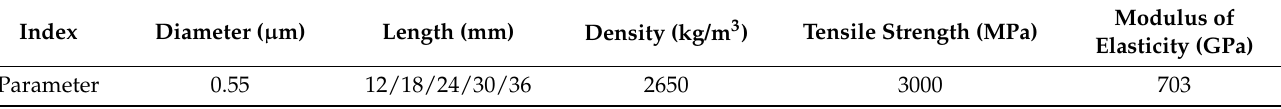
Figure 1. The five lengths of basalt fiber: ( a ) L = 12 mm; ( b ) L = 18 mm; ( c ) L = 24 mm; ( d ) L = 30 mm; and ( e ) L = 36 mm; and ( f ) a schematic diagram of the different fiber lengths. Table 2. The physical and mechanical properties of the basalt